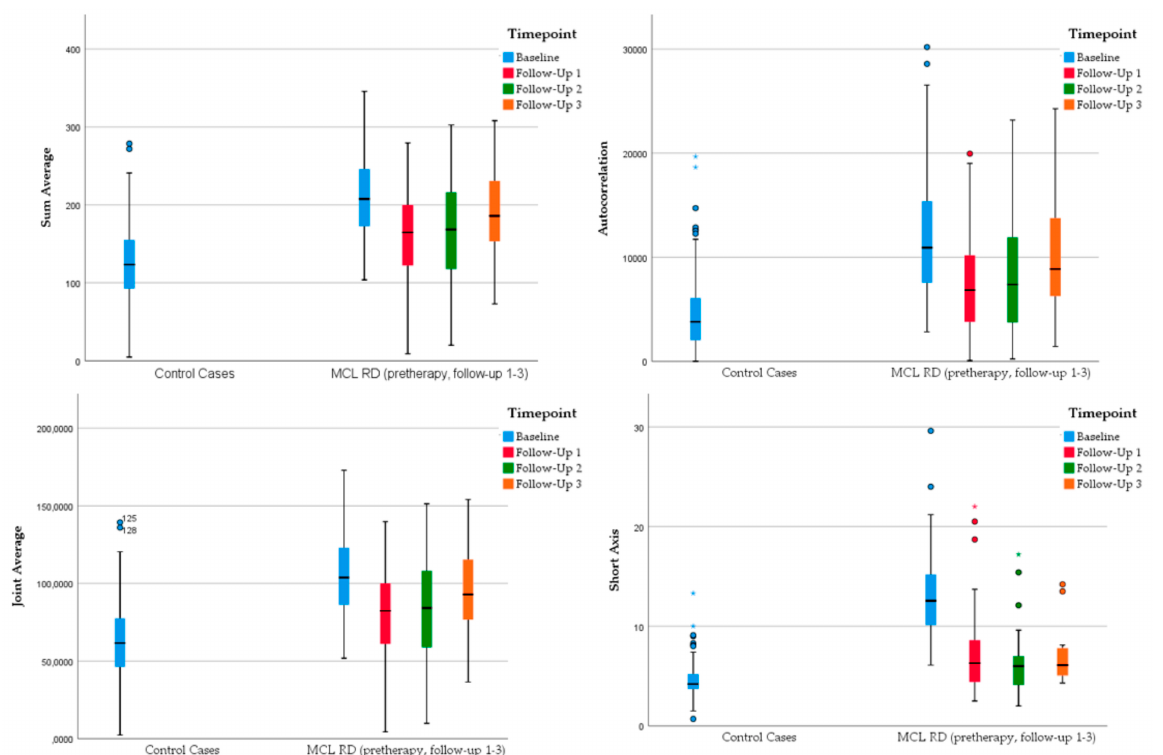
Figure 5. Grouped boxplots representing changes in specific radiomic parameters of MCL patients with relapse of disease (MCL RD) with continued significant differences to the control cases with normal lymph nodes at the pretherapy and all follow-up imaging with opposing values compared to the remission group at the follow-up imaging at 6 and 12 months, respectively. * represents an outlier defined as a data point that is located outside 1.5 times the interquartile range above the upper quartile or below the lower